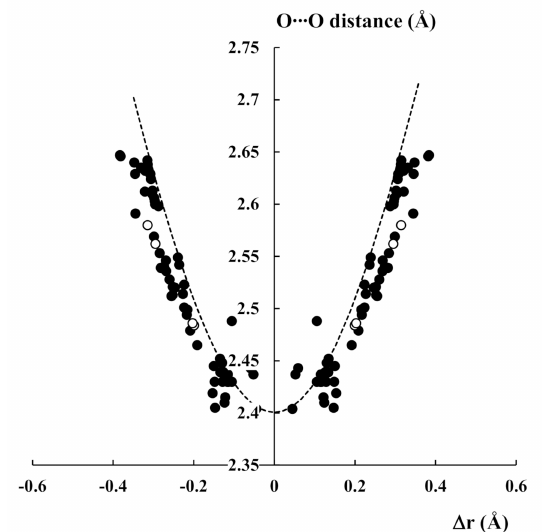
Figure 1. The dependence between the ∆ r (Å) - the displacement of the proton (or deuter) position from the O ··· O mid-point and the O ··· O distance (Å), for the O-H ··· O systems (black circles) and the O-D ··· O ones (white circles). The broken line corresponds to the bond number conservation rule (Equation